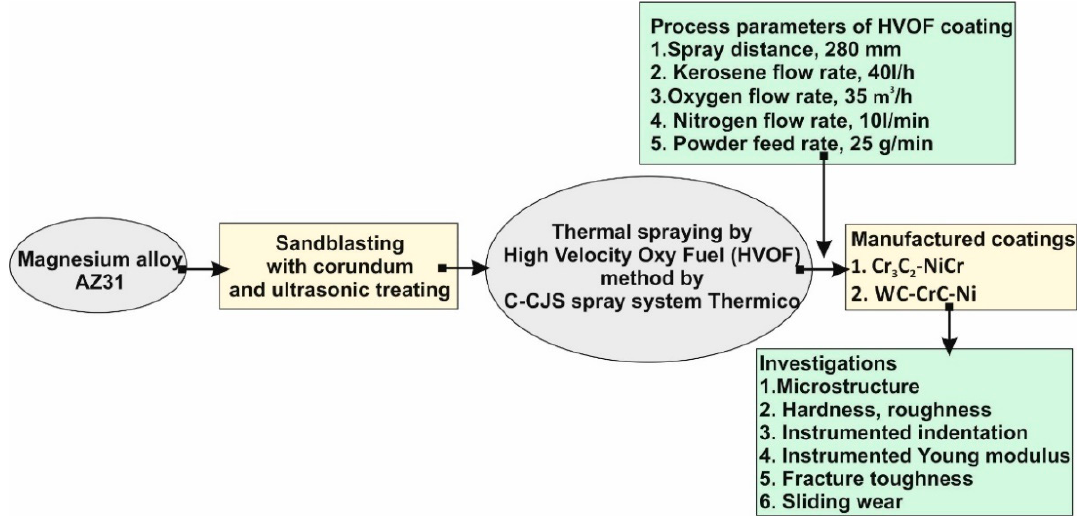
Figure 2. Schematic diagram of the manufacturing process and analysis method for WC and CrC coatings.